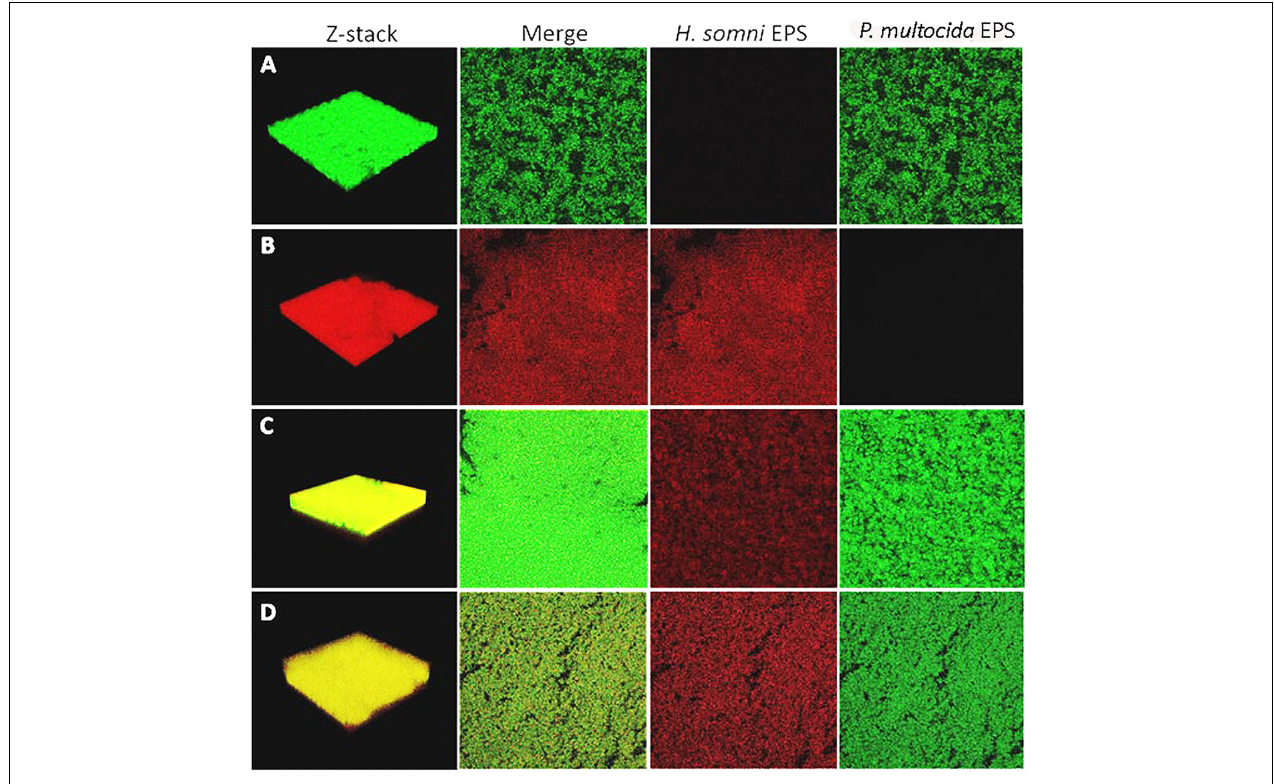
FIGURE 3 | Fluorescently tagged lectin staining of in vitro biofilm EPS. Moringa M labeled with TRITC was used as the specific lectin for the galactomannan EPS from H. somni , and Griffonia simplicifolia labeled with FITC was used as the specific lectin for the glycogen EPS of P. multocida. (A) P. multocida strain C0513-P5 single species biofilm Z-stack, the merged view of images with each lectin, H. somni strain 2336 EPS, P. multocida strain C0513-P5 EPS. (B) H. somni strain 2336 single species biofilm Z-stack, the merged view of images with each lectin, H. somni strain 2336 EPS, P. multocida strain C0513-P5 EPS. (C) Polymicrobial biofilm with P. multocida C0513-P5 Z-stack, the merged view of images with each lectin, H. somni strain 2336 EPS, P. multocida strain C0513-P5 EPS. (D) Polymicrobial biofilm with P. multocida C0513 Z-stack, the merged view of images with each lectin, H. somni strain 2336 EPS, P. multocida strain C0513 EPS. TABLE 2 | COMSTAT analysis of fluorescently tagged lectin staining of in vitro biofilm EPS. a Polymicrobial Biomass ( µ m 3 / µ m 2 ) Average Thickness ( µ m) Roughness Coefficient (0 –